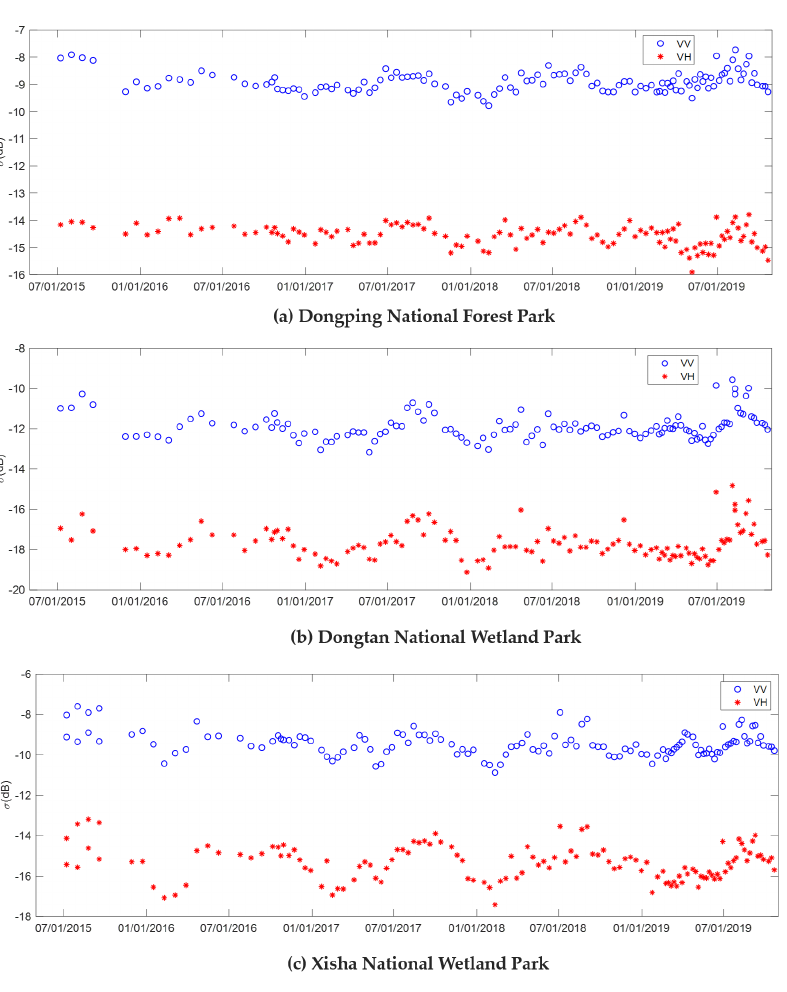
Figure 14. Available VV and VH data from 2015 to 2019 for Chongming island.